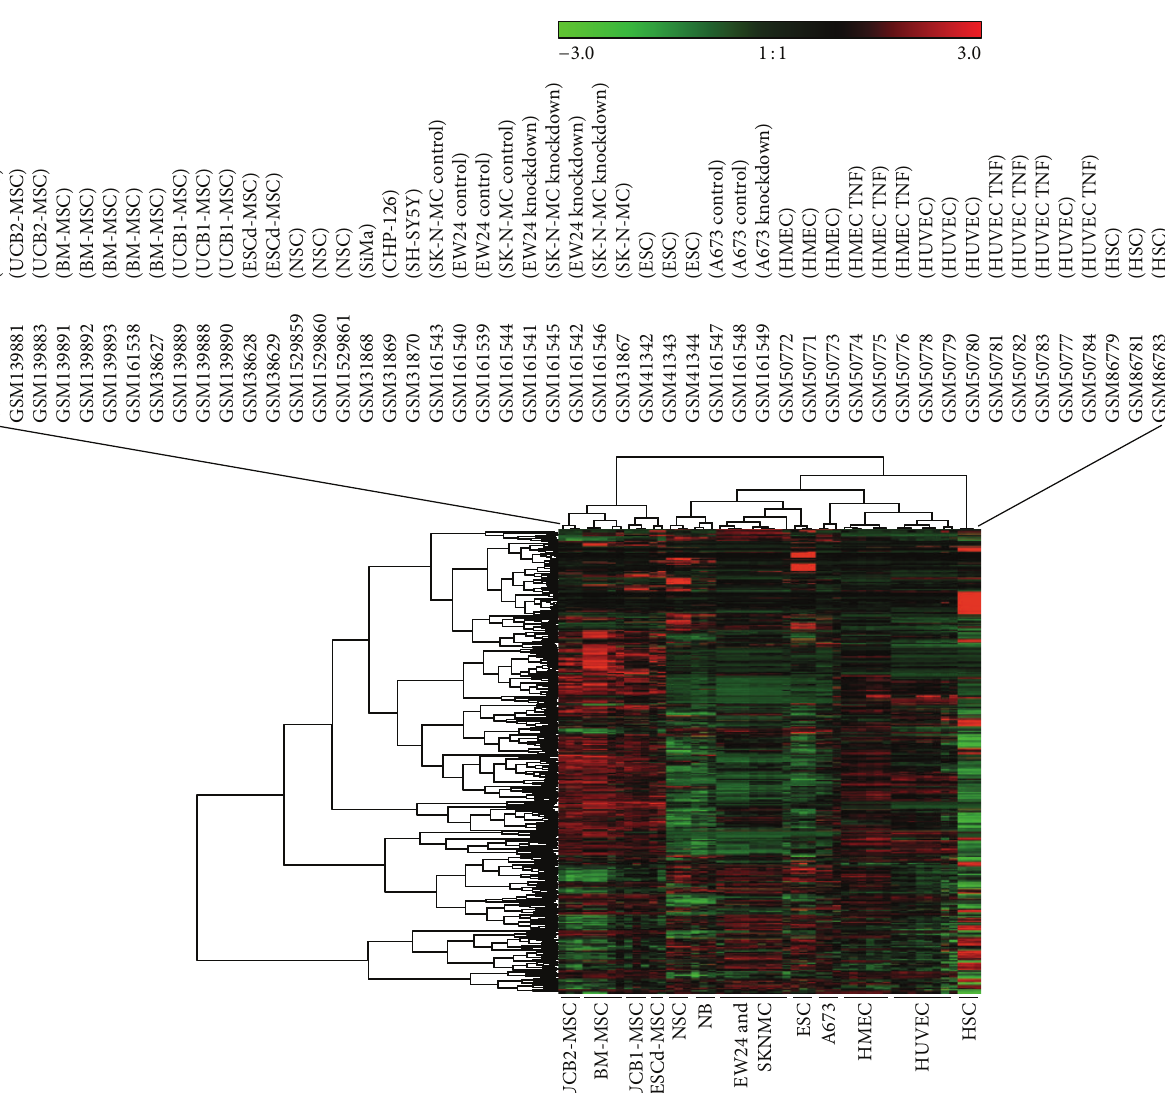
Figure 4: Similarities in the stem cell signature between Ewing sarcoma cells and endothelial cells. DNA microarray cel files from stem cells were processed as described in the caption of Figure 1. DNA microarray data from these stem cells were combined with a panel of microvasculature endothelial cells (HMEC) [20], macrovasculature endothelial cells (HUVEC) [20], neuroblastoma cell lines (NB) [1], and the Ewing sarcoma cell lines A673, EW24, and SK-N-MC [1, 3]. After RMA normalization, transformation into melodies was performed using the GEMusicA implementation in R. For this end, only the probe sets from the prefiltered stem cell signature from Figure 1 were used. The following parameters were used: minfreq = 27.5 , tonesteps = 12 , numkeys = 88 , mindur = 8 , vol = 4 , TeXscalefactor = 1 , maxNdots = 2 , and 𝑁 = 1114 . Presented is a cluster analysis of the GEMusicA-processed probe sets (Manhattan distance, complete linkage